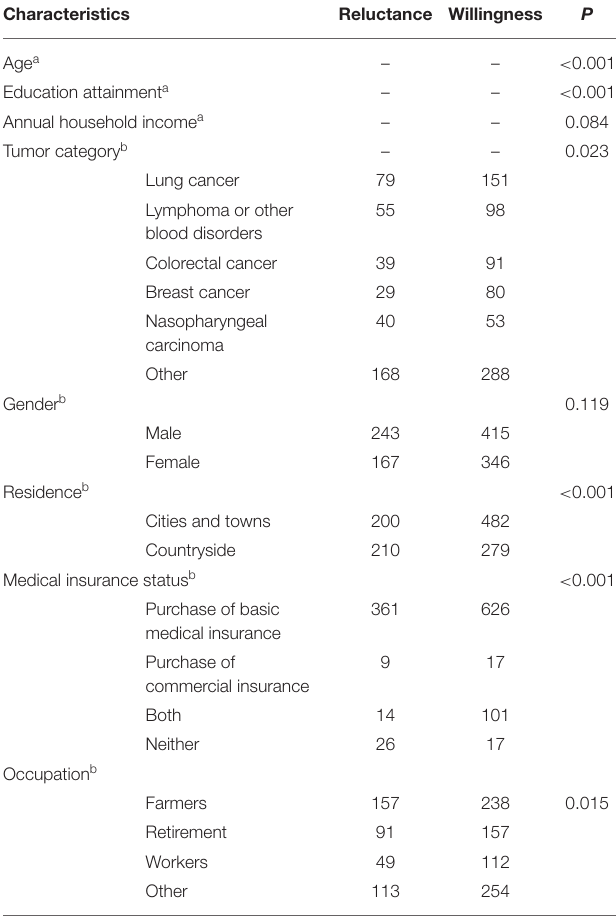
TABLE 4 | Correlation analysis of willingness to pay for medical treatment on the Internet.